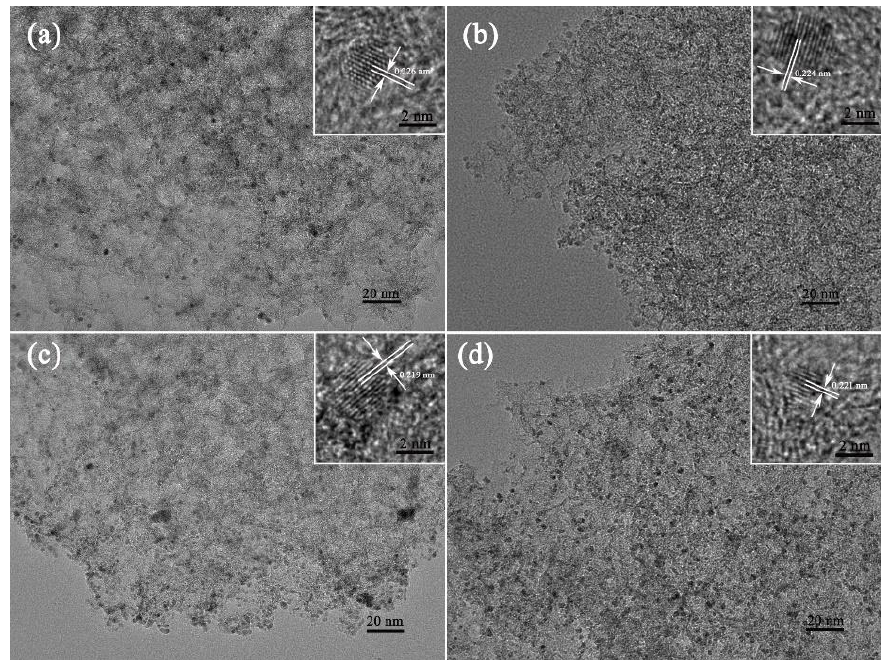
Figure 1. TEM and HRTEM (inset) images of ( a ) Pt/CN, ( b ) Pd/CN, ( c ) Rh/CN and ( d ) Ir/CN.